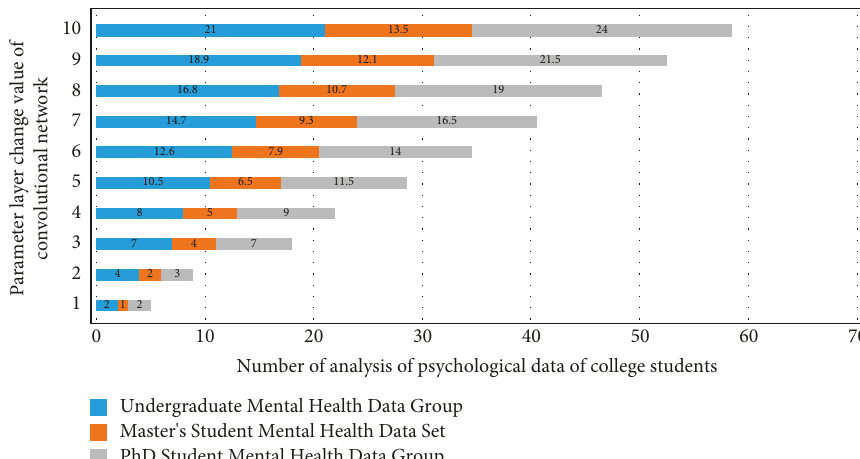
Figure 6: Preliminary experimental analysis results of mental health problems in college students after dimensionality reduction.